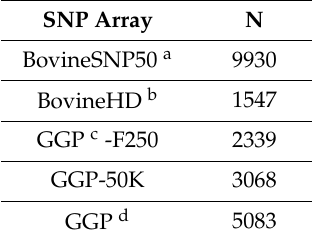
Table 1. Animals genotyped in the Germplasm Evaluation